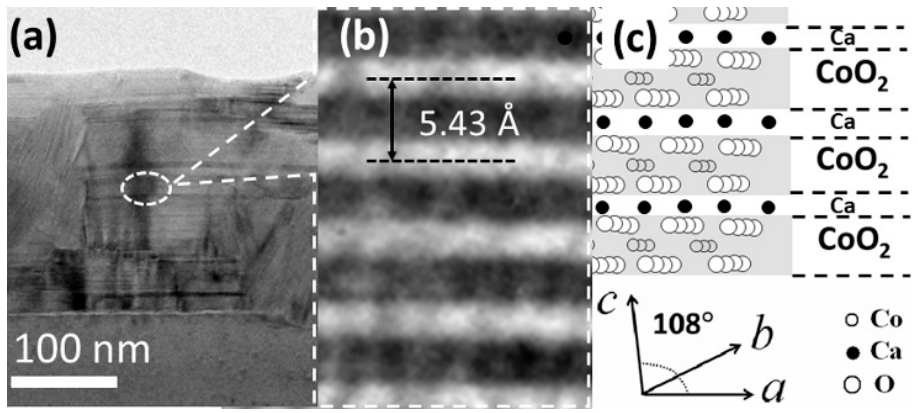
Figure 5. ( a ) TEM image of Ca 0.33 CoO 2 film, ( b ) Lattice-resolved TEM image and ( c ) schematic of the atomic arrangement of the layers.